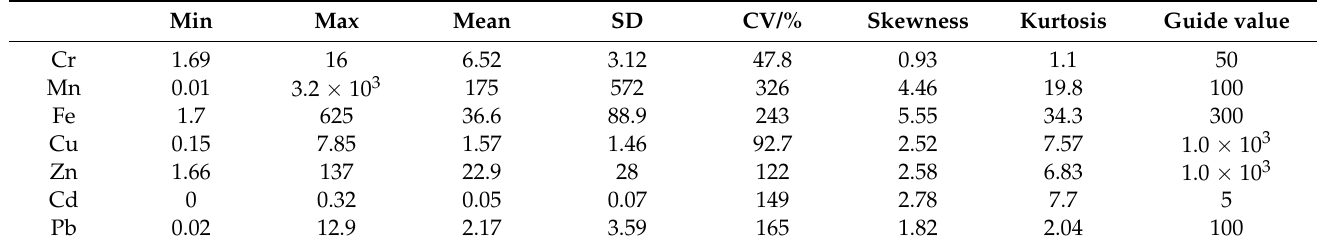
Table 1. Statistical summary of concentrations of heavy metals ( µ g/L) in groundwater in Hainan Island. Min Max Mean SD CV/% Skewness Kurtosis Guide